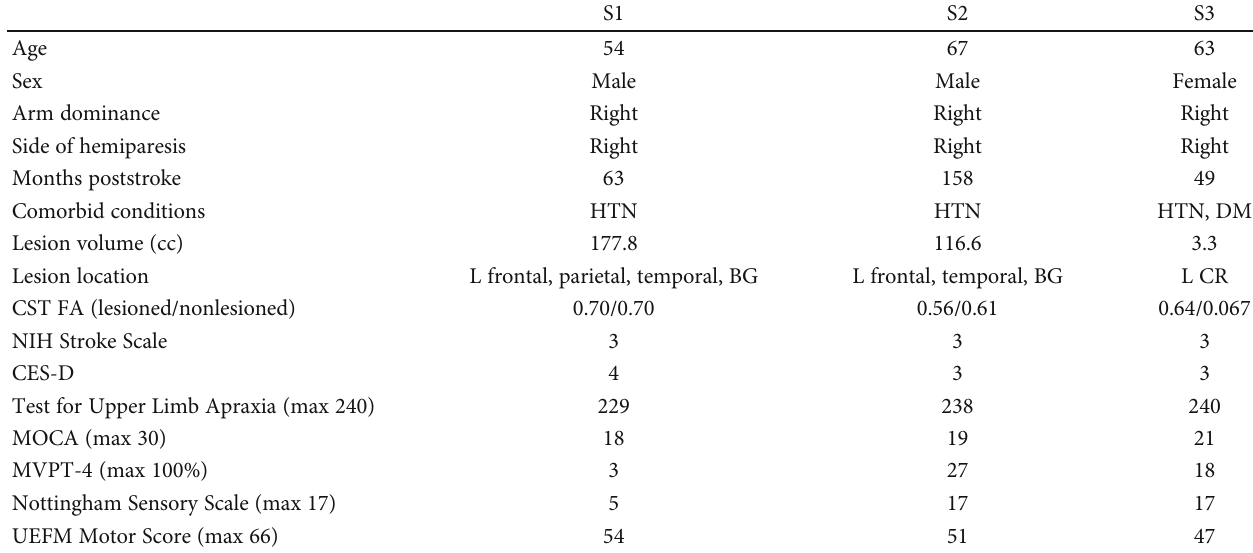
Table 1: Participant